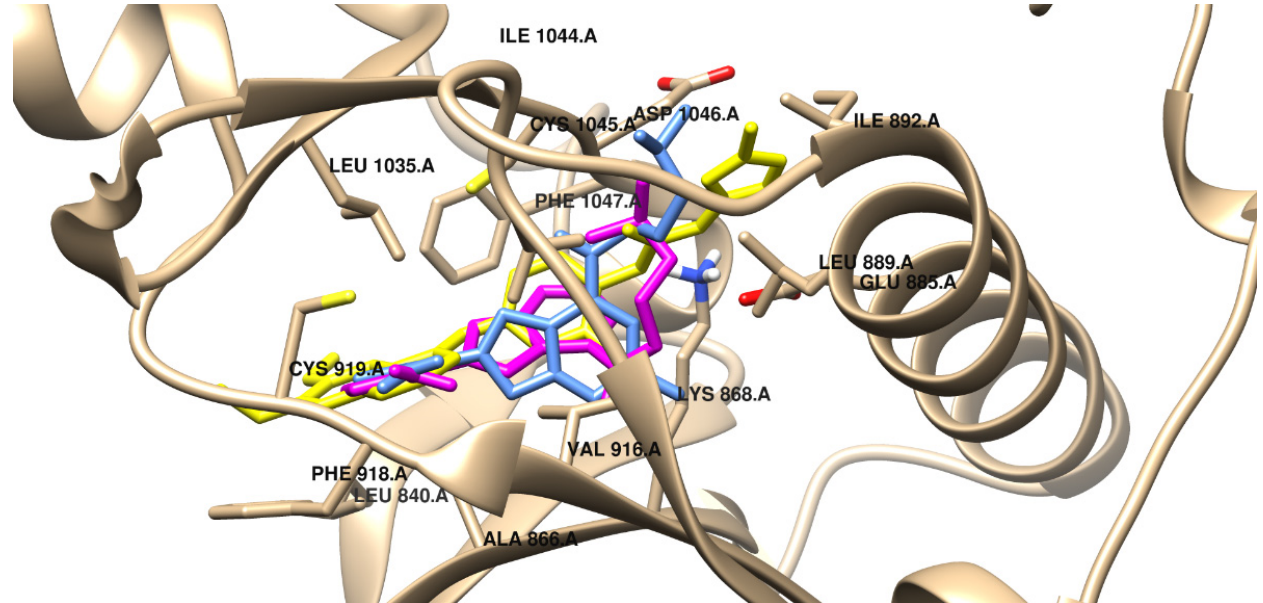
Figure 8. The binding pose of the most potent designed inhibitor 3g (magenta), the 5-methyl analog of compound 3g ( SCM9 ) (blue), and tivozanib (yellow) in the active center of VEGFR-2.